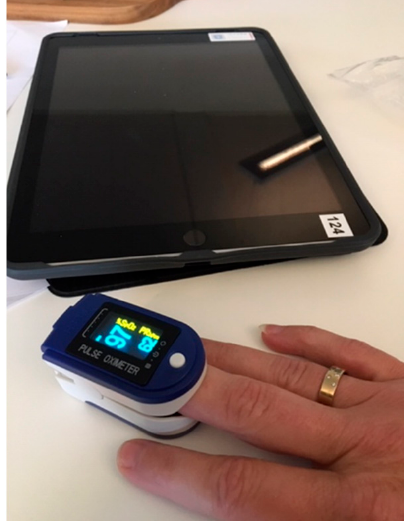
Figure 1. Appliance for measuring oxygen saturation at home.